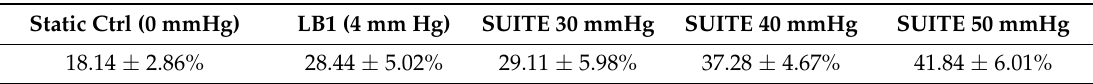
Table 2. Quantitative analysis of the expression of vWF in HUVEC (percentage of red fluorescent area with respect to the total area cell covered area of images) for static and dynamic (LB1) controls and in SUITE at different overpressures.